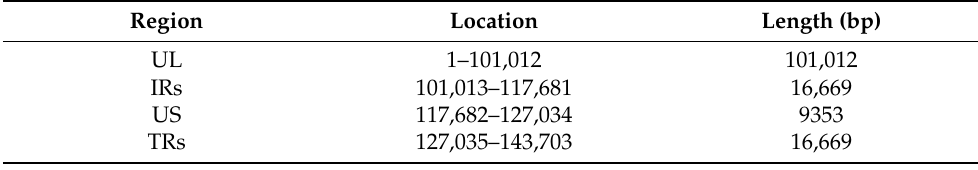
Table 2. Nucleotide sequence coordinates and lengths are given relative to the genome sequence of PRV FJ strain.